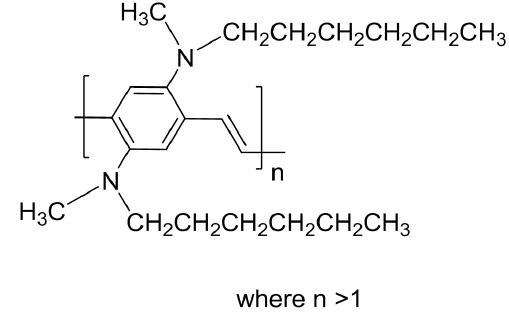
Figure 3. Structure of poly(2,5-bis( N -methyl- N -hexylamino)phenylene vinylene)